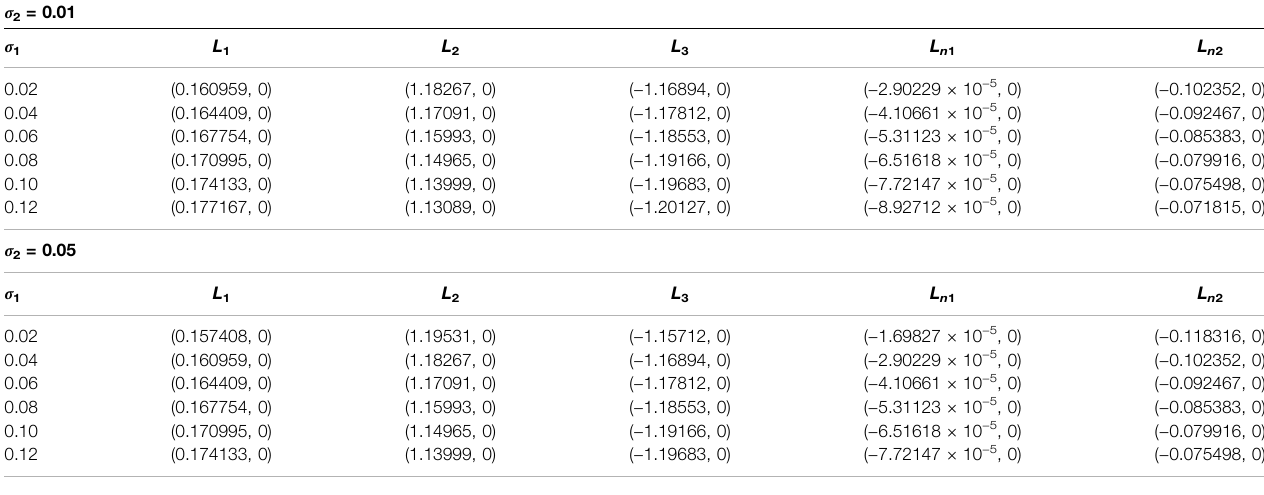
TABLE 8 | Positions ( x 0 , 0) of the collinear points of the binary HD155876 system for fi xed values q 1 = 0.979950, q 2 = 0.983912, A 3 = 0.02, M b = 0.06, T = 0.01, ′ (cid:1) 2 × 10 − 5 , σ ′ (cid:1) 10 − 5 , and for two fi xed values of σ σ 1 2